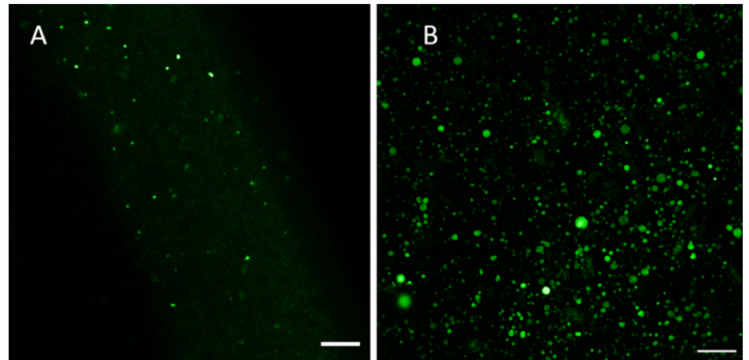
Figure 6. Fluorescence micrographs revealing the BBR-loaded liposomes (before extrusion) generated by the thin-film hydration method: ( A ) Sample FH21, scale bar 10 µ m, wavelength 802.9 nm; ( B ) Sample FH12, scale bar 50 µ m, wavelength 488